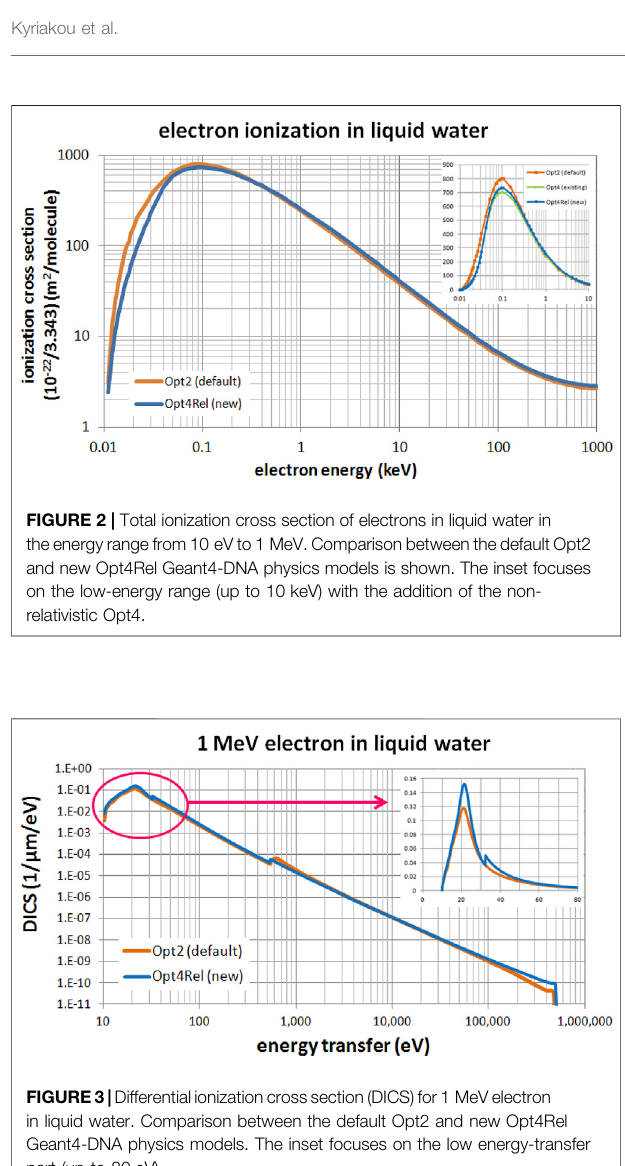
Frontiers in Physics |